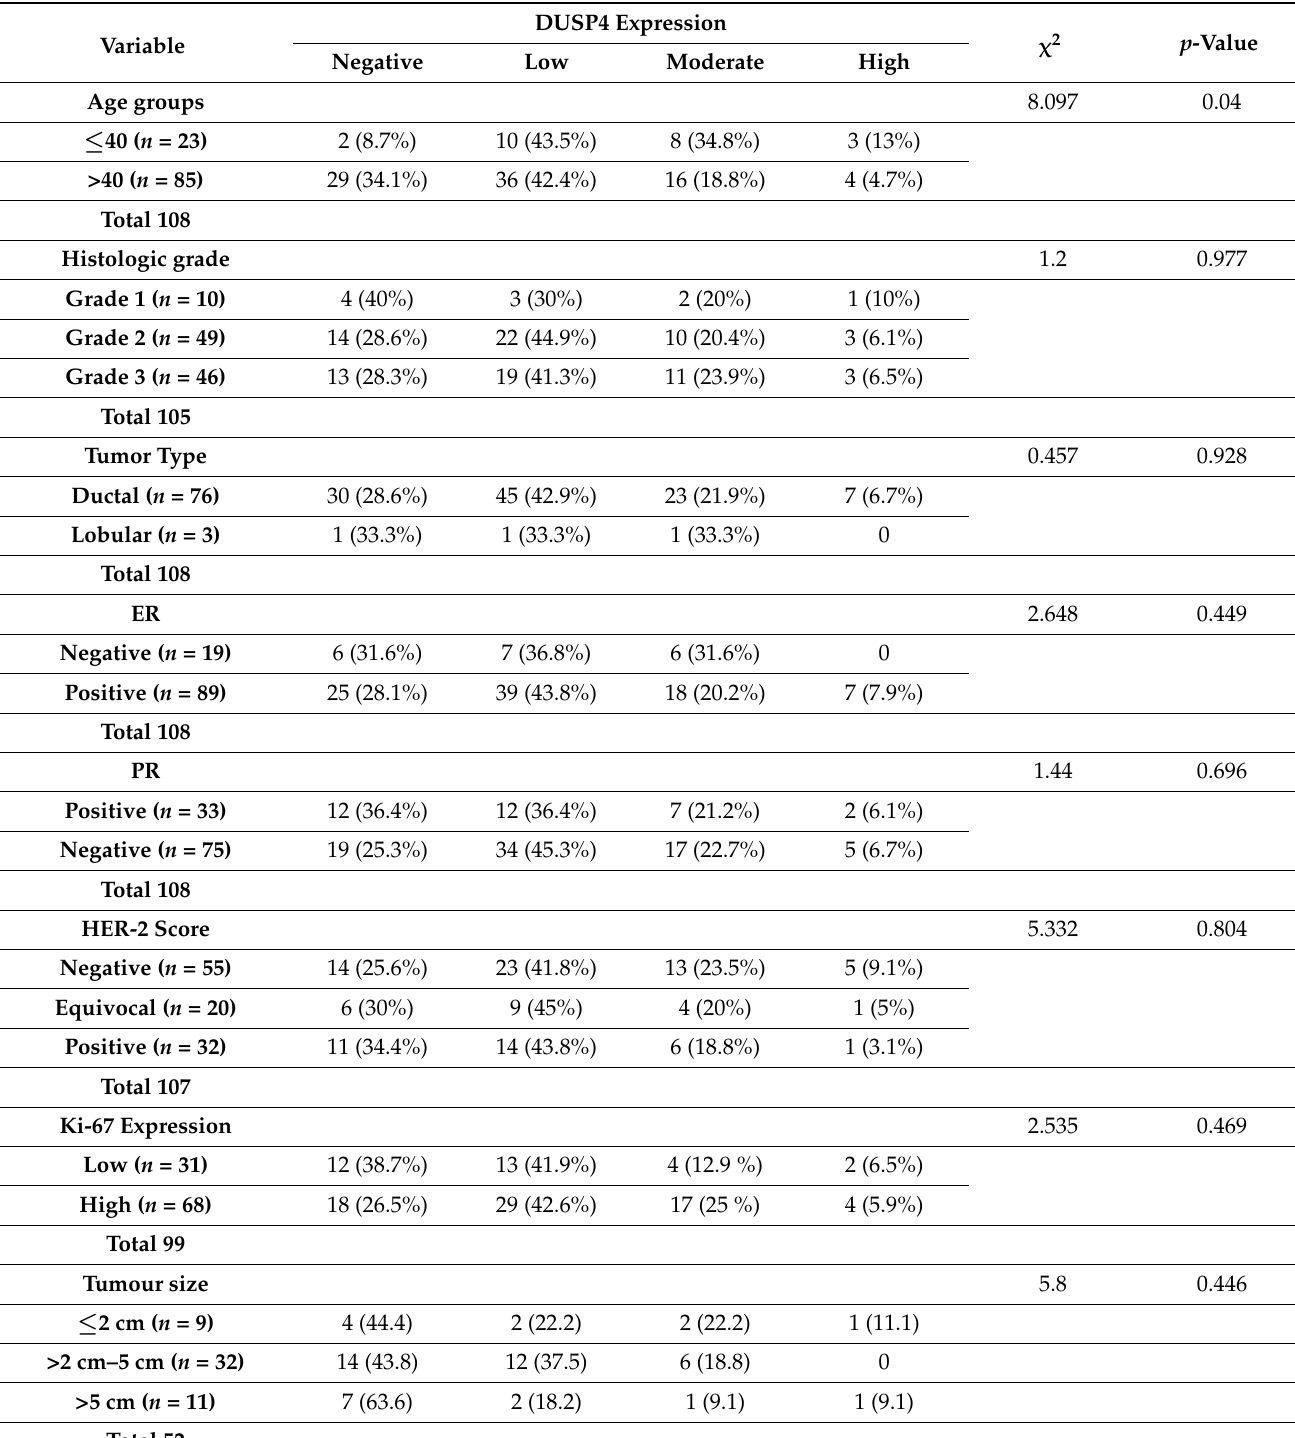
Table 1. Patient’s Clinicopathological Characteristics and DUSP4